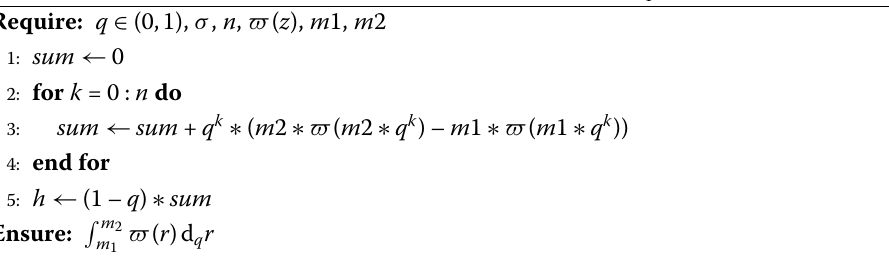
Algorithm 4 The pseudo-code to compute different values